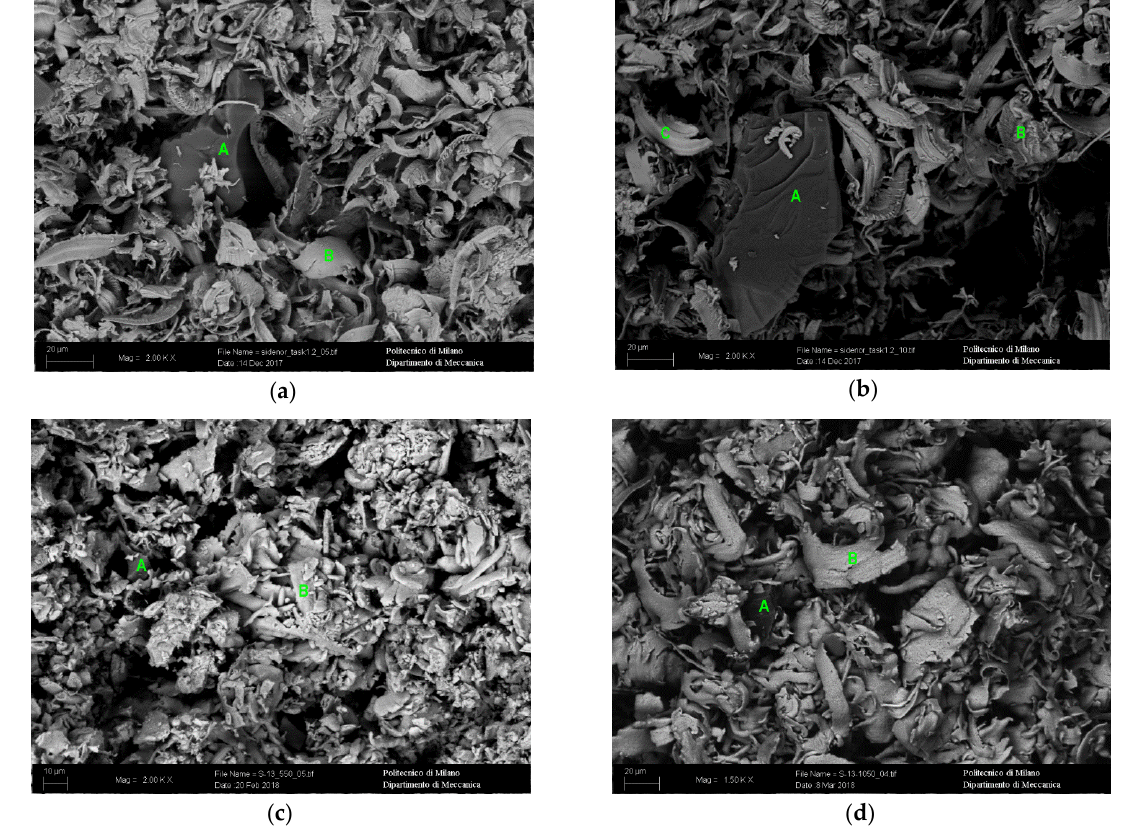
Figure 3. SEM micrographs of ( a , b ) as-received, ( c ) 550 °C and ( d ) 1050 °C treated grinding sludge samples. Table 3. SEM–energy-dispersive X-ray spectroscopy (SEM-EDS) analysis of as-received and thermal-treated grinding sludge samples.